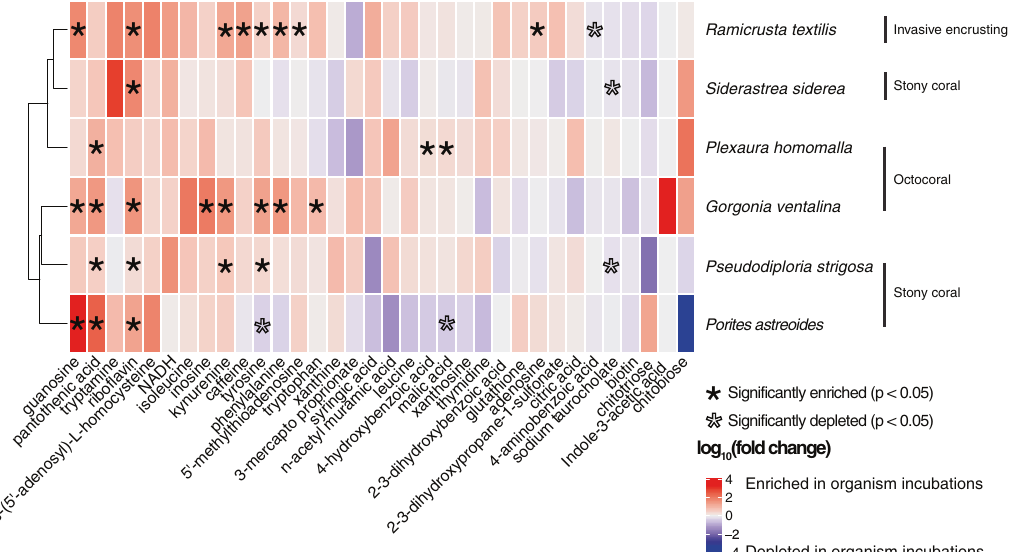
Fig. 1 Heatmap of average log 10 (fold changes) between organism and control incubations demonstrates that speci fi c targeted metabolites are signi fi cantly enriched and depleted and vary by species. Colors correspond to log 10 (fold change) and asterisks re fl ect signi fi cantly enriched (black) or depleted (outlined) metabolites in organism compared to control incubations as determined using Welch ’ s